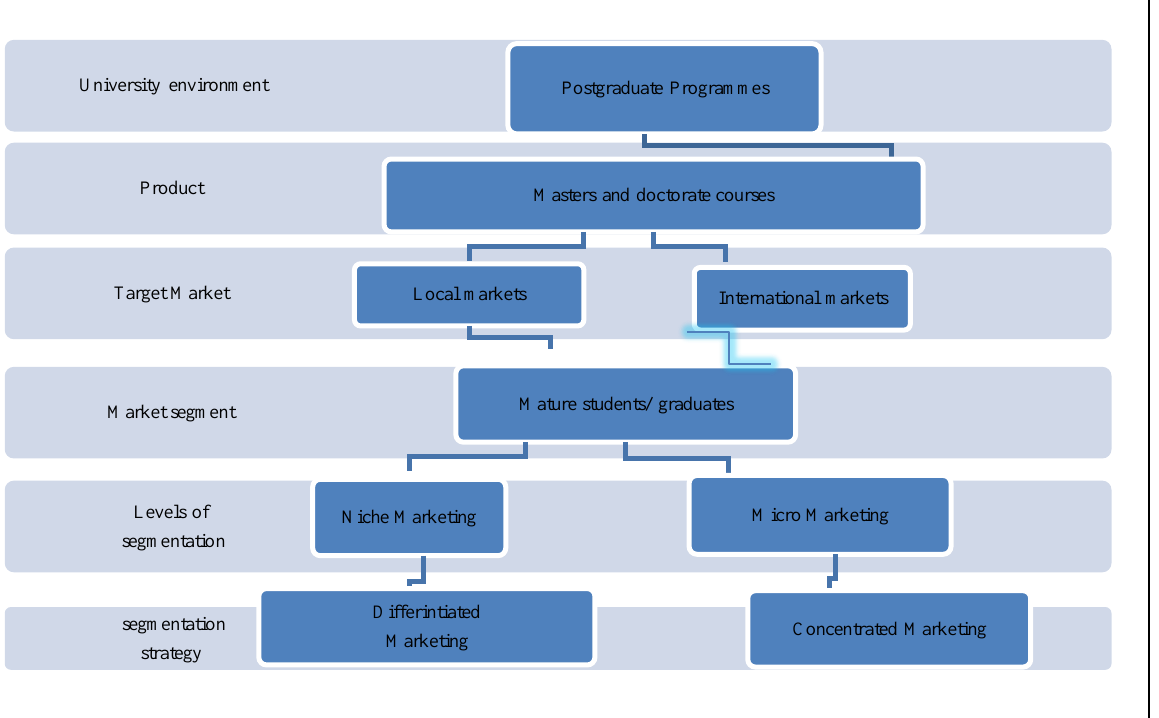
Figure 1: Postgraduate market; Source: Own conceptualisation Positioning refers to designing the image and value of the product within target segments to maximise the organisation's benefits. Positioning “can be achieved in the consumer’s mind through brand symbols, brand marks, logos, and other brand characteristics” (Kotler and Keller, 2016: 297). The success of products and services is also dependent on the marketing mix. In the higher education sector, the marketing mix refers to all the marketing tools that are useful in creating a demand for university services (Ndoferi et al, 2020: 243). Mlambo (2017: 94); Vusudeva and Mogaji, (2020: 155 and 164) identified the main positioning dimensions